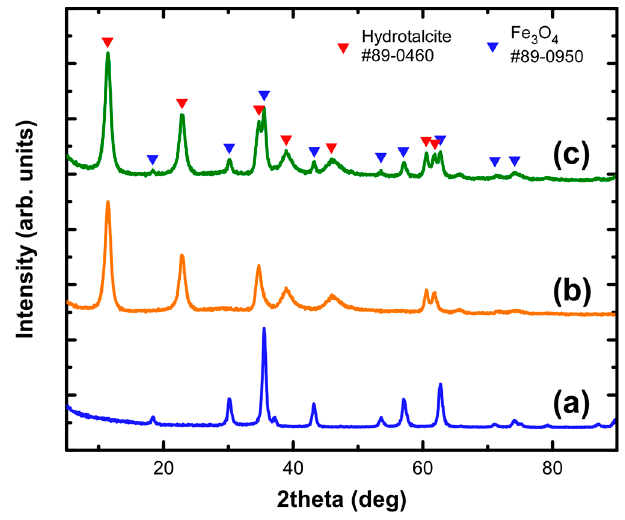
Figure 3. XRD diagrams of the IONPs ( a ), pure hydrotalcite ( b ) and MGT-35 ( c ). The presence of Fe 3 O 4 instead of γ -Fe 2 O 3 as the dominant iron oxide was verified after determination of the Fe 2+ /Fe 3+ ratio at around 0.41 very close to the expected stoichiometry for magnetite (0.5). Overall, the chemical analysis indicated the percentages of Fe: 22.7 wt.%, Mg: 13.5 wt.%, Al: 7.2 wt.% for sample MGT-20 and Fe: 39.8 wt.%, Mg: 11.0 wt.%,